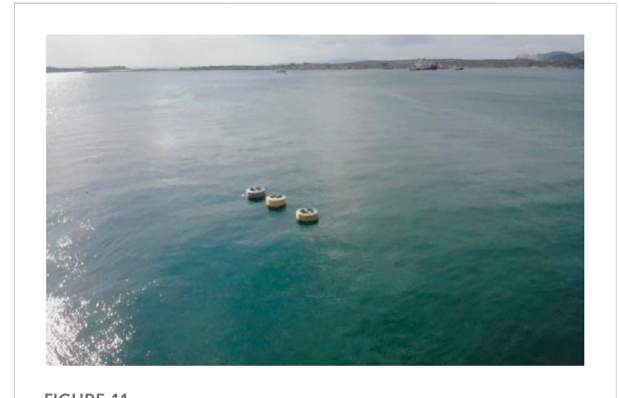
FIGURE 11 Snapshot from the fi rst day of the experiment.